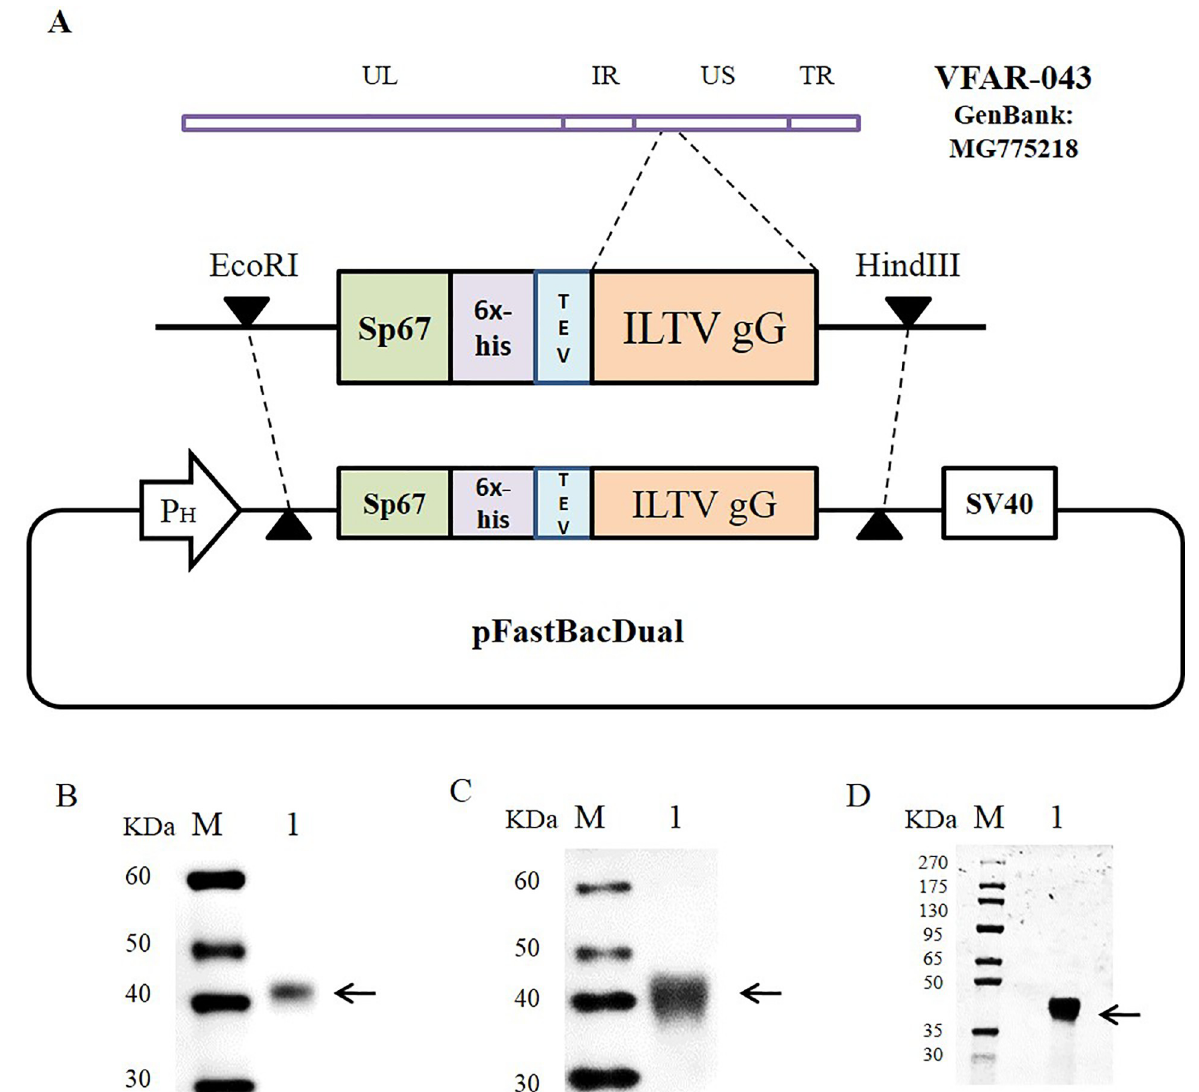
Fig 1. Expression of the ILTV gG recombinant protein using baculovirus. (A) Strategy for cloning ILTV gG from the VFAR-043 strain into pFastBacDual. (B) Western blot detection of secreted ILTV gG from infected Sf9 insect cell supernatants using anti-6x-His tag antibodies. (C) Western blot detection of secreted ILTV gG from infected Sf9 insect cell supernatants using serum from ILTV-infected chicken (Charles Rivers Laboratories). (D) SDS-PAGE detection of purified ILTV gG by Coomassie blue staining. Lane M: Molecular weight marker; Lane 1: ILTV gG recombinant protein. Black arrows indicate the ILTV gG recombinant